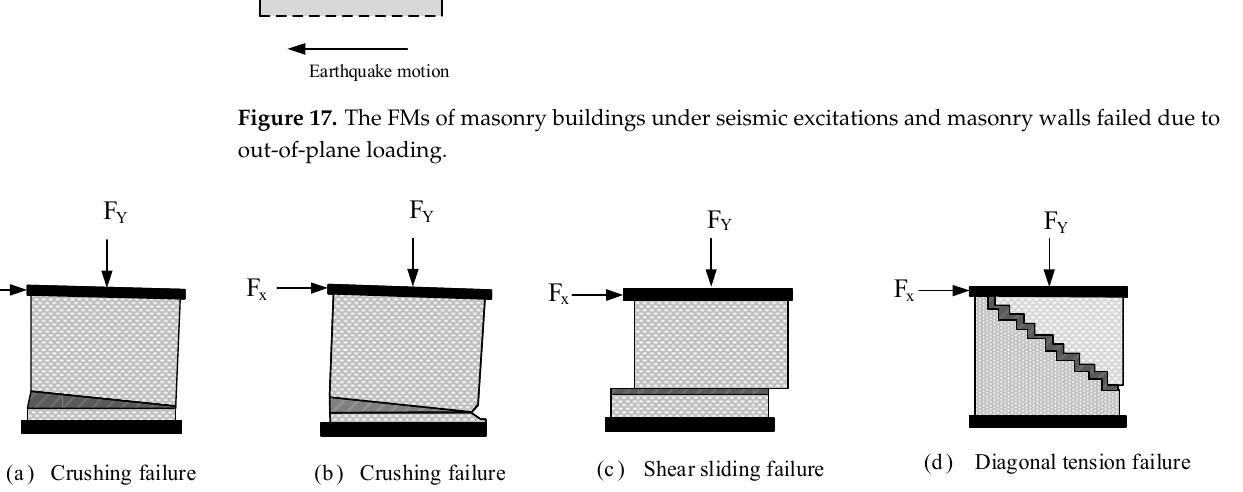
Figure 18. The FMs of unstrengthened masonry walls.